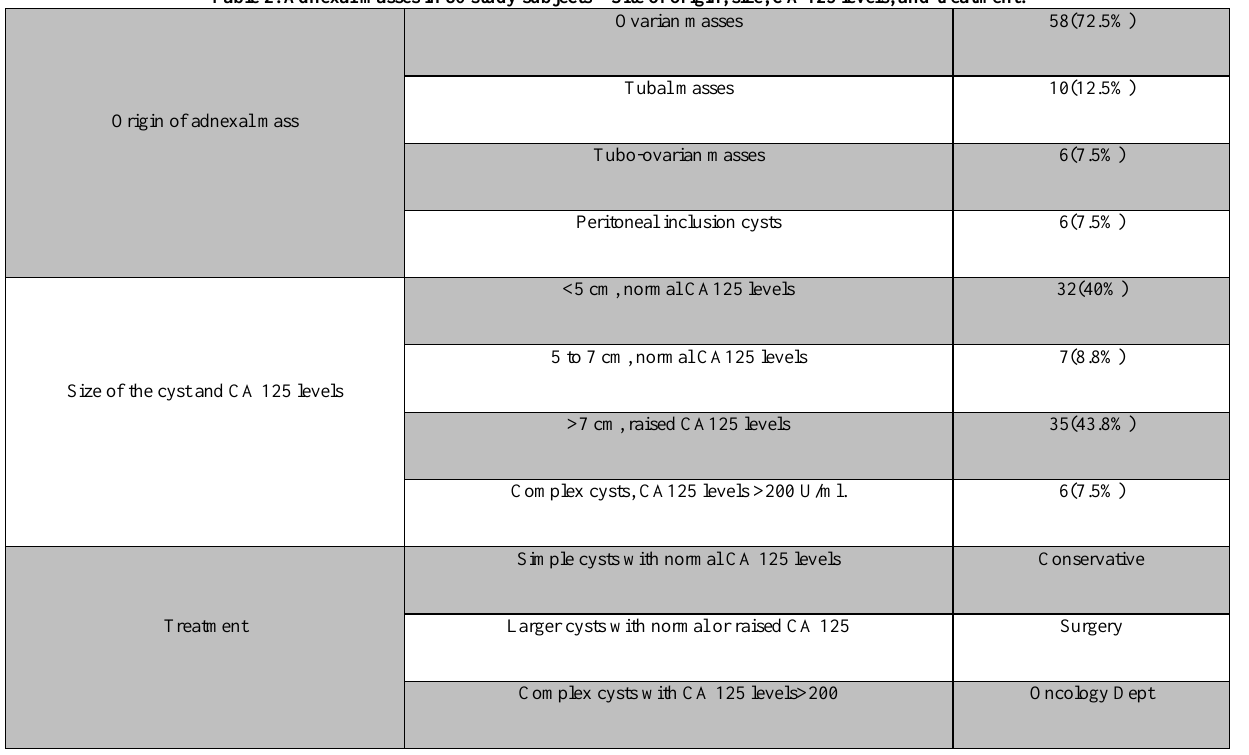
Table 2. Adnexal masses in 80 study subjects – Site of origin, size, CA 125 levels, and